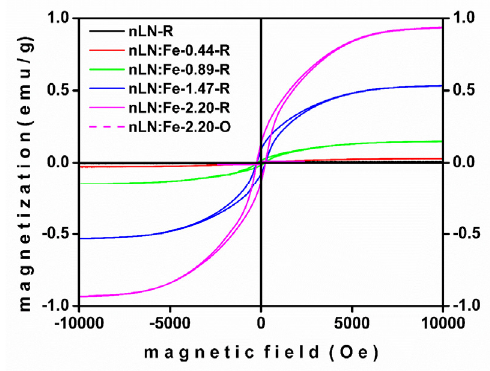
Figure 5. Comparison between the magnetic hysteresis loops of reduced samples with different Fe-doping concentration also is presented the hysteresis loop of oxidized sample with 2.20% of Iron.